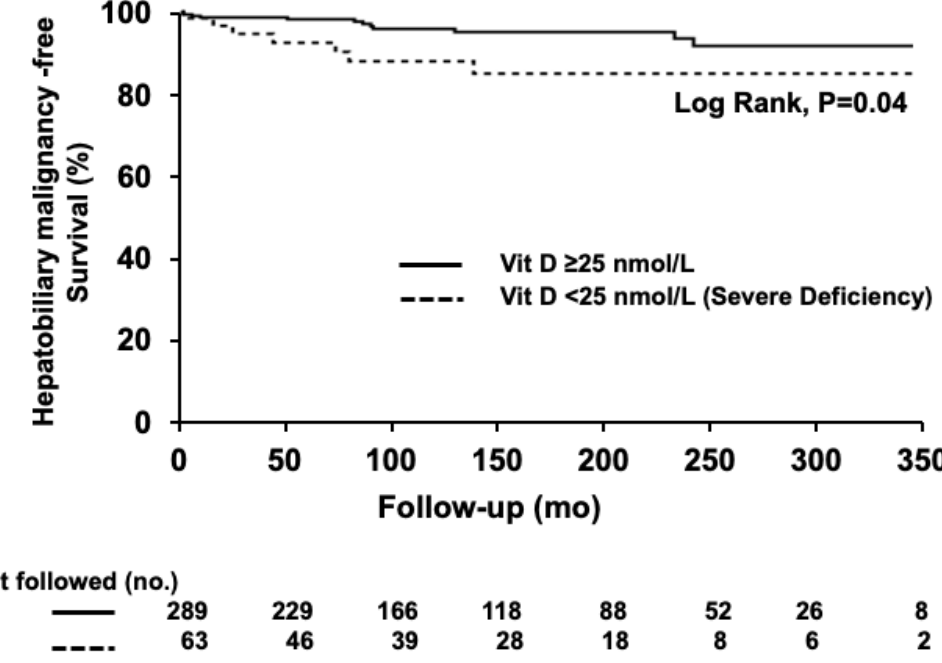
Figure 1. Hepatobiliary malignancy-free survival according to the status of severe vitamin D deficiency.